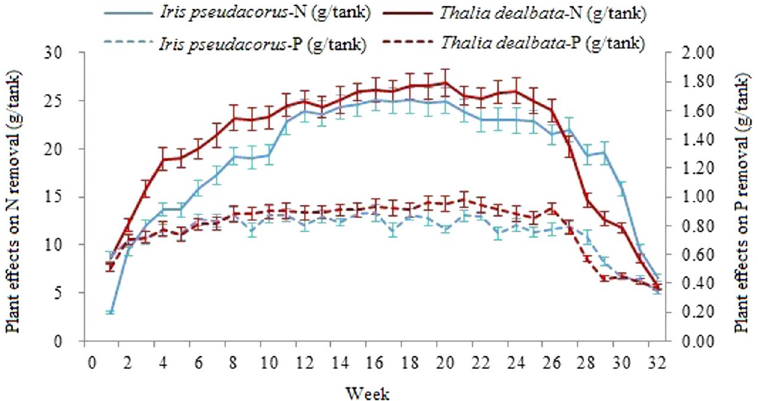
Figure 1. Vegetation effects on mass removal in one experimental tank (mean, n = 3). Each tank contained one FTW with nine plants. Weekly accumulated P and N mass removal in the Iris pseudacorus and Thalia dealbata FTWs treatment system at each time step were obtained to estimate net contribution of the plant uptake and associated microbial activities in the FTW